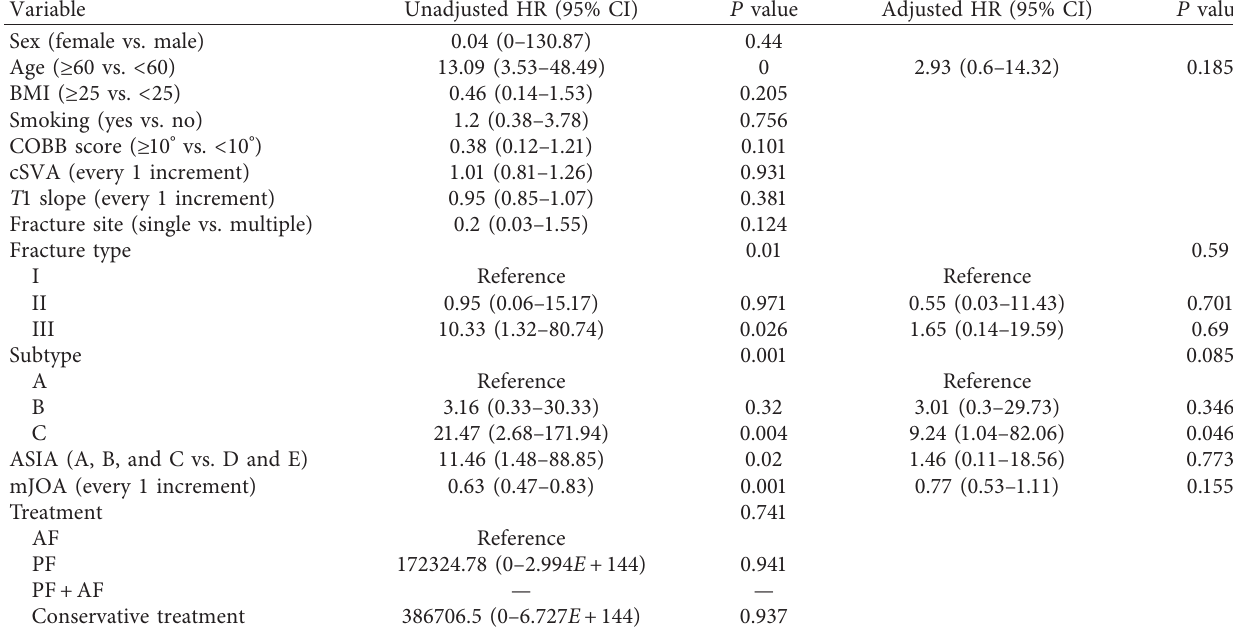
Table 4: COX and